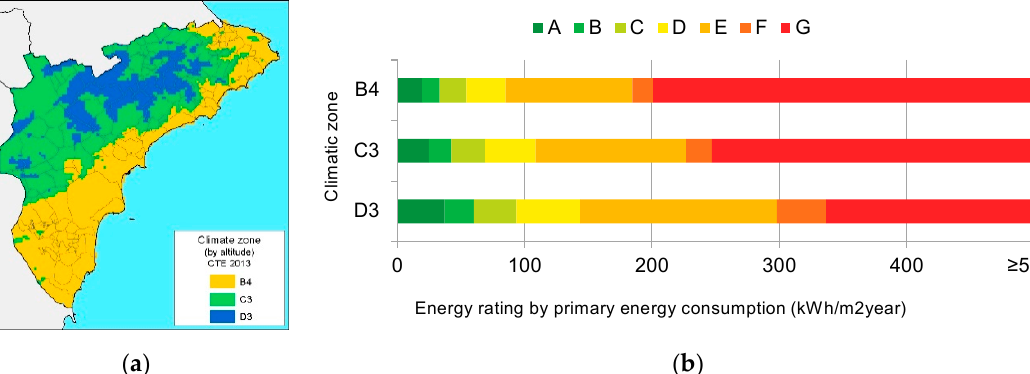
Figure 2. ( a ) Climatic areas in the Alicante province; ( b ) energy rating by primary energy consumption (kWh/m 2 year) for homes and buildings, according to climate zone, obtained from the CE3 programme and the CTE 2013 regulations.